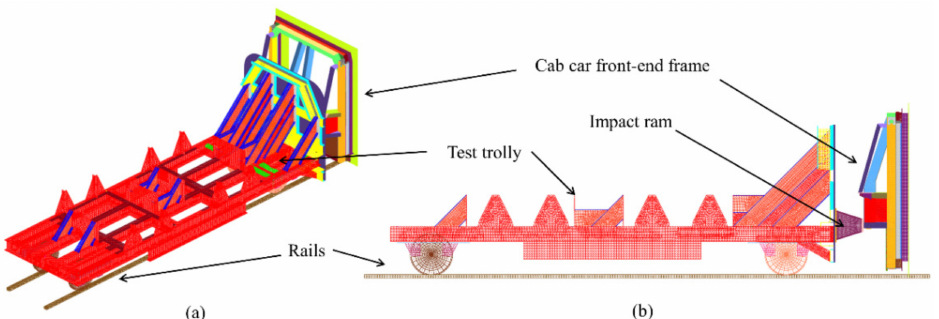
Figure 6. Finite element model: ( a ) isometric view; ( b ) Left